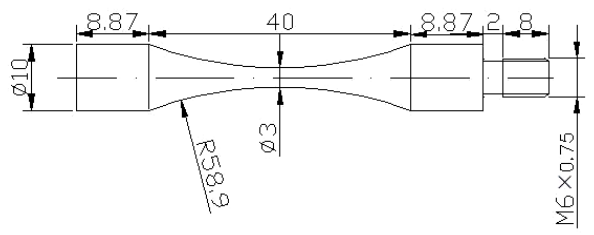
Figure 2. Shape and dimensions of the test specimens (unit: mm).